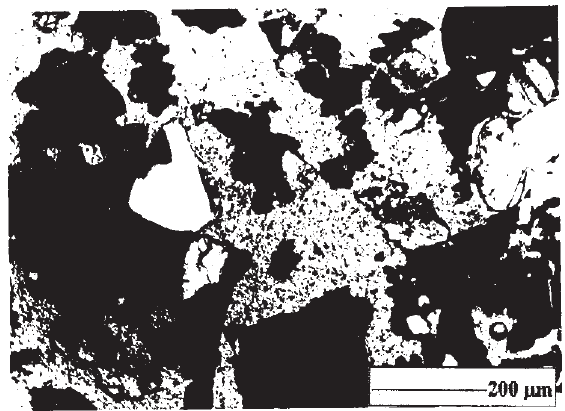
Figura 2. Horizonte Ap do perfil sob cultivo há 18 anos, mostrando microagregados arredondados isolados e ligados uns aos outros, constituindo uma microestrutura com forte influência da atividade biológica (1/2 XPL).